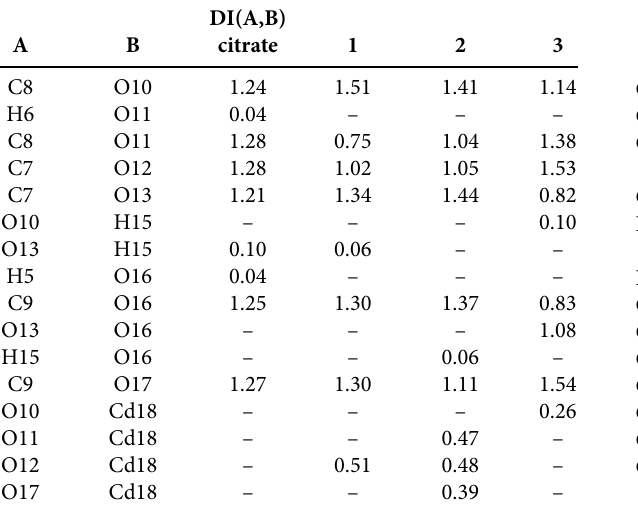
Table 2. Delocalization Indices of citrate ion and structures 1–3.